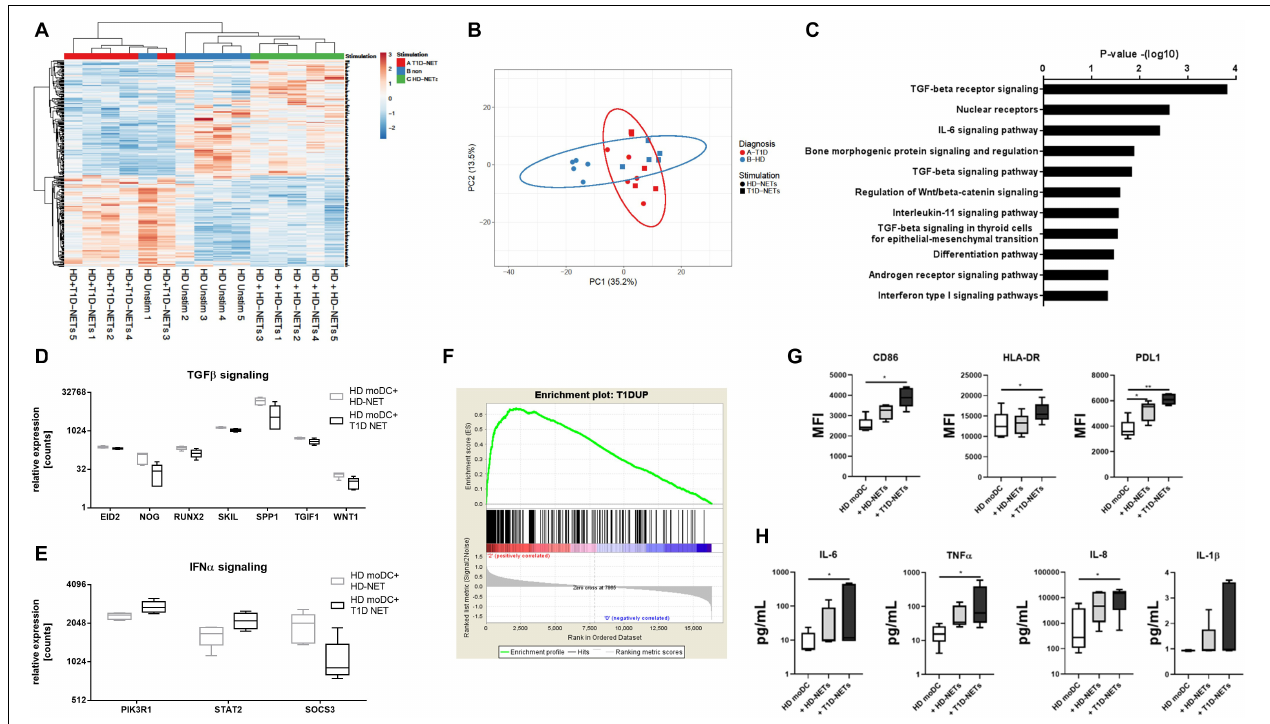
FIGURE 4 | Analysis of RNA-Seq data from HD moDCs stimulated with autologous NETs versus HD moDCs stimulated with heterologous T1D NETs. (A) Cluster analysis of HD unstimulated moDCs, stimulated with autologous NETs and heterologous NETs. (B) principal component analysis (PCA) of HD and T1D moDCs stimulated with autologous NETs or heterologous T1D NETs (C). WikiPathways analysis of enriched pathways involved in moDC after NET stimulation (D) and (E) relative expression of enriched genes involved in TGF β and IFN α signaling (F) GSEA (gene set enrichment analysis) of created a T1D signature gene set containing 1568 DEGs that were differentially expressed between unstimulated healthy moDCs and unstimulated T1D moDCs, divided into those that were upregulated and downregulated in T1D compared to HD. moDC from healthy donor ( n = 5) (40% female) were cultivated with autologous healthy NETs (HD-NETs), heterologous T1D-NETs or left untreated for 24 h and their (G) phenotype determined by flow cytometry and (H) cytokine production analyzed by Luminex were evaluated. Statistical analysis was performed using unpaired t -tests. Values of p < 0.05 (*) and p < 0.01 (**) were considered statistically